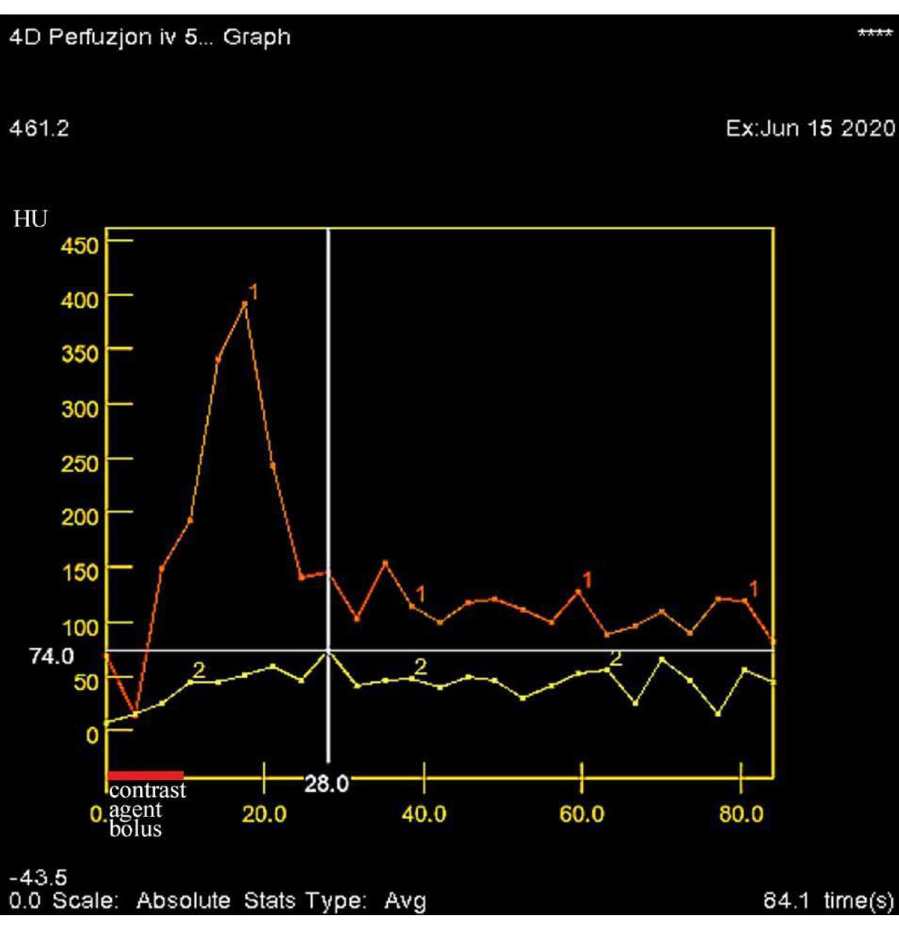
Figure 2. An example of CTP scanning . The contrast enhancement of the aorta is marked in red and the flow in the SPN is marked in yellow. The contrast bolus lasts for 10 s and begins simultaneously with the commencement of the scan. The greatest contrast enhancement of the tumor to + 74 HU is observed 28 s after contrast administration. CTP perfusion computed tomography.